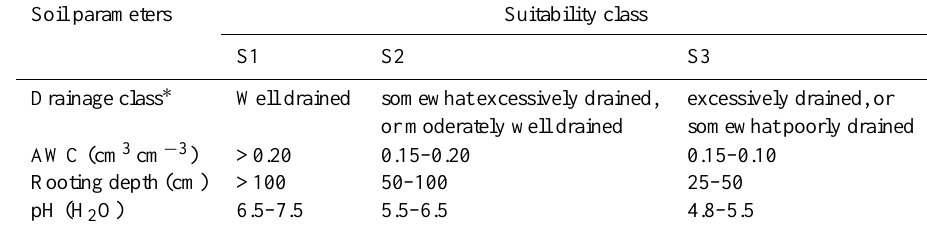
Table 2. Functional soil parameters and suitability classes of the potential new areas for viticulture in the Azores.